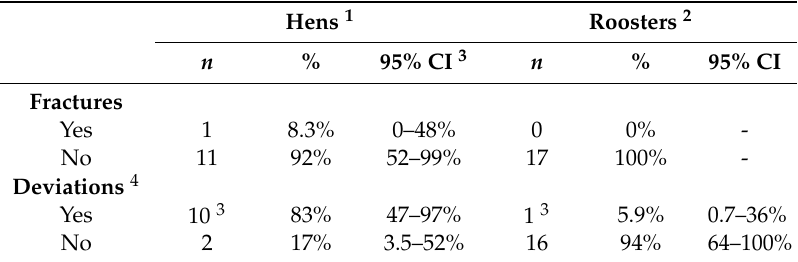
Table 1. Overview of keel bone findings in the jungle fowl.